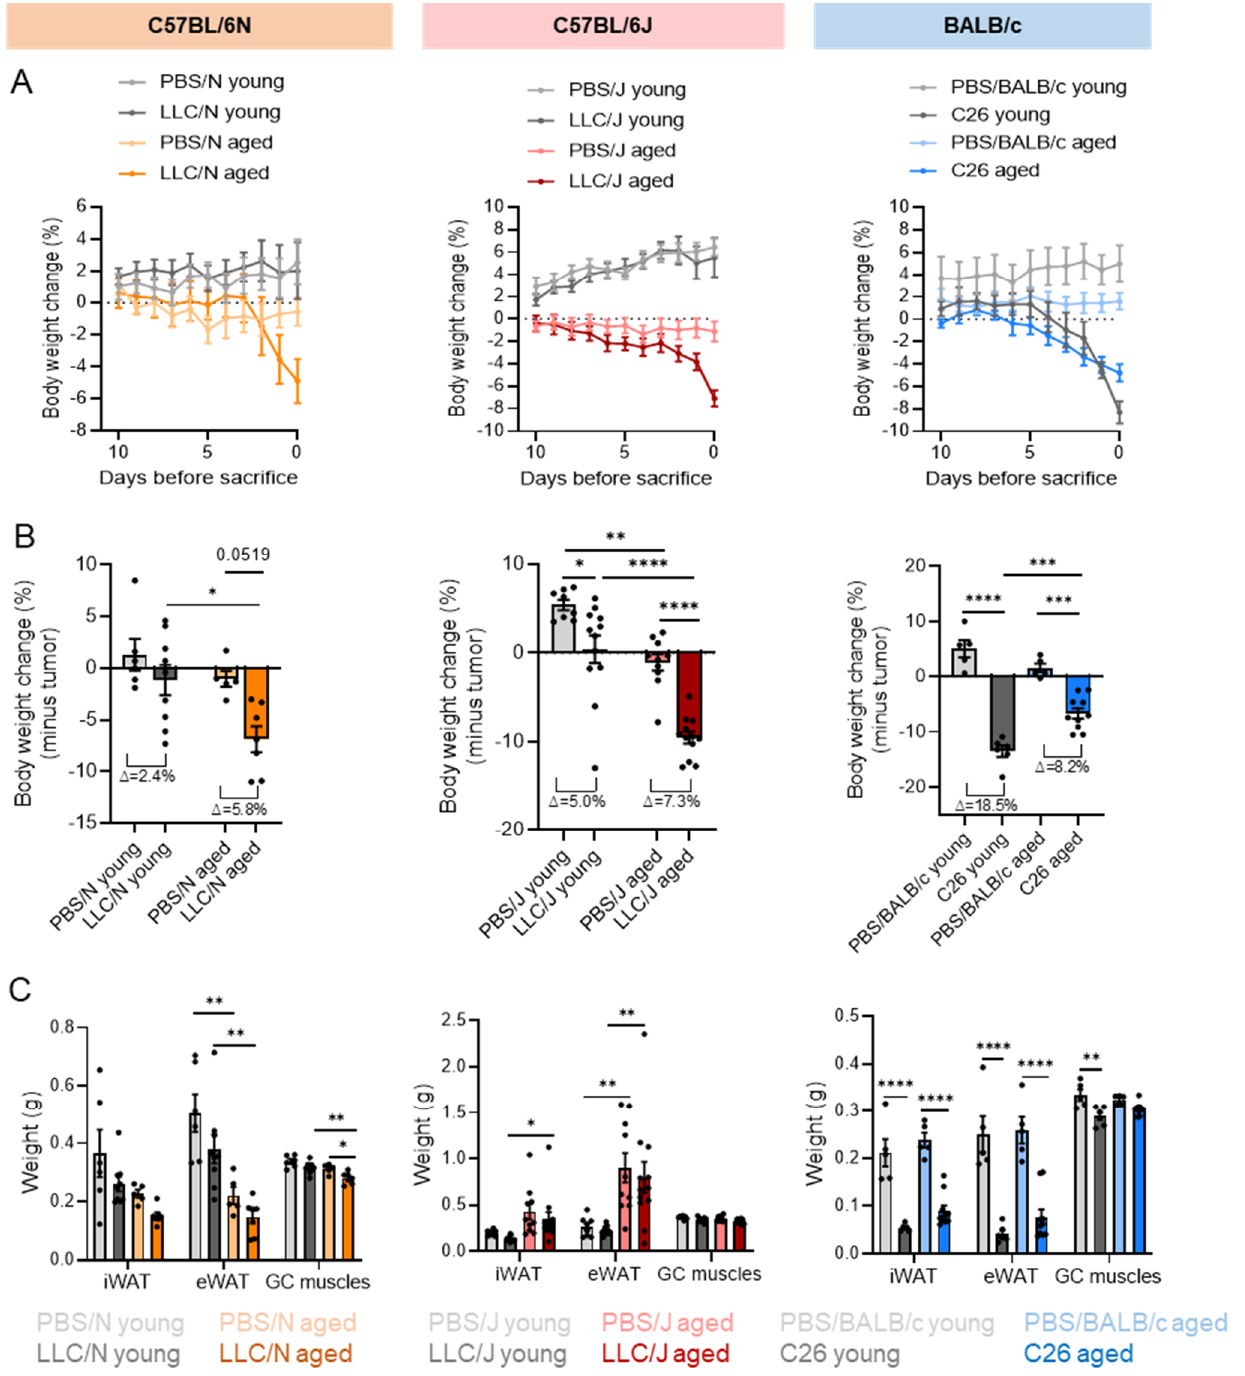
Figure 2. Strain-dependent differences in cancer-induced weight loss development. ( A – C ) Mice of different ages were injected with either PBS (control) or a tumor cell line (LLC or C26). Young adult mice (grey lines and bars) injected with PBS are depicted in light grey (PBS/N young n = 6, PBS/J young n = 8, PBS/BALB/c young n = 5), young mice injected with a tumor cell line are shown in dark grey (LLC/N young n = 9, LLC/J young n = 12, C26 young n = 6). Aged mice injected with PBS are depicted in light colors (PBS/N aged n = 5-light orange, PBS/J aged n = 10-light red, PBS/BALB/c aged n = 5-light blue), while aged mice injected with a tumor cell line are shown in dark colors (LLC/N aged n = 7-dark orange, LLC/J aged n = 12-dark red, C26 aged n = 10-dark blue). ( A ) Time course of body weight development (change in percentage compared to initial body weight before injection). ( B ) Change of body weight minus tumor compared to initial mass (expressed as percentage). ( C ) Tissue weights of inguinal white adipose tissue (iWAT), epididymal WAT (eWAT),